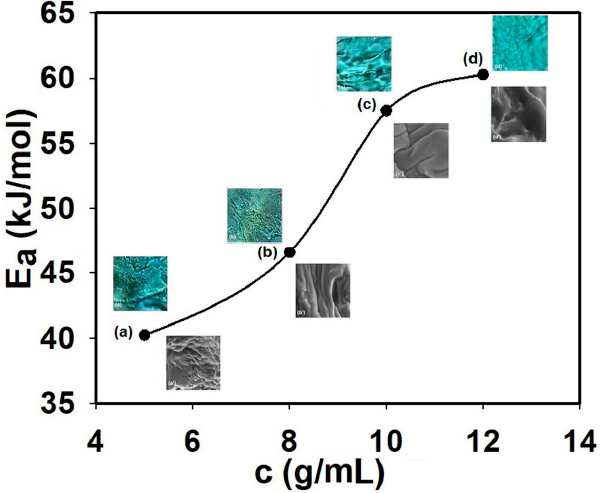
Figure 7. Dependence of activation energy as a function of PSFEtP + solution concentration in DMF at 25 °C. Small images represent POM and SEM images recorded for PFEtP + samples at studied concentrations: 5.01 g/mL (a), 8.02 g/mL (b), 10.06 g/mL (c), 12.43 g/mL (d).